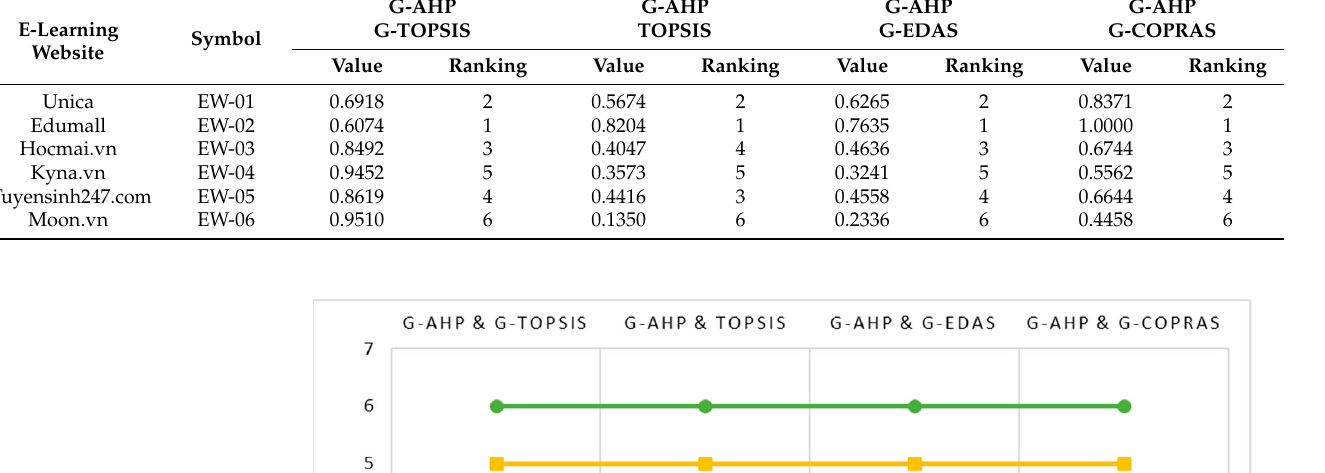
Table 11. Ranking results of compared methods.